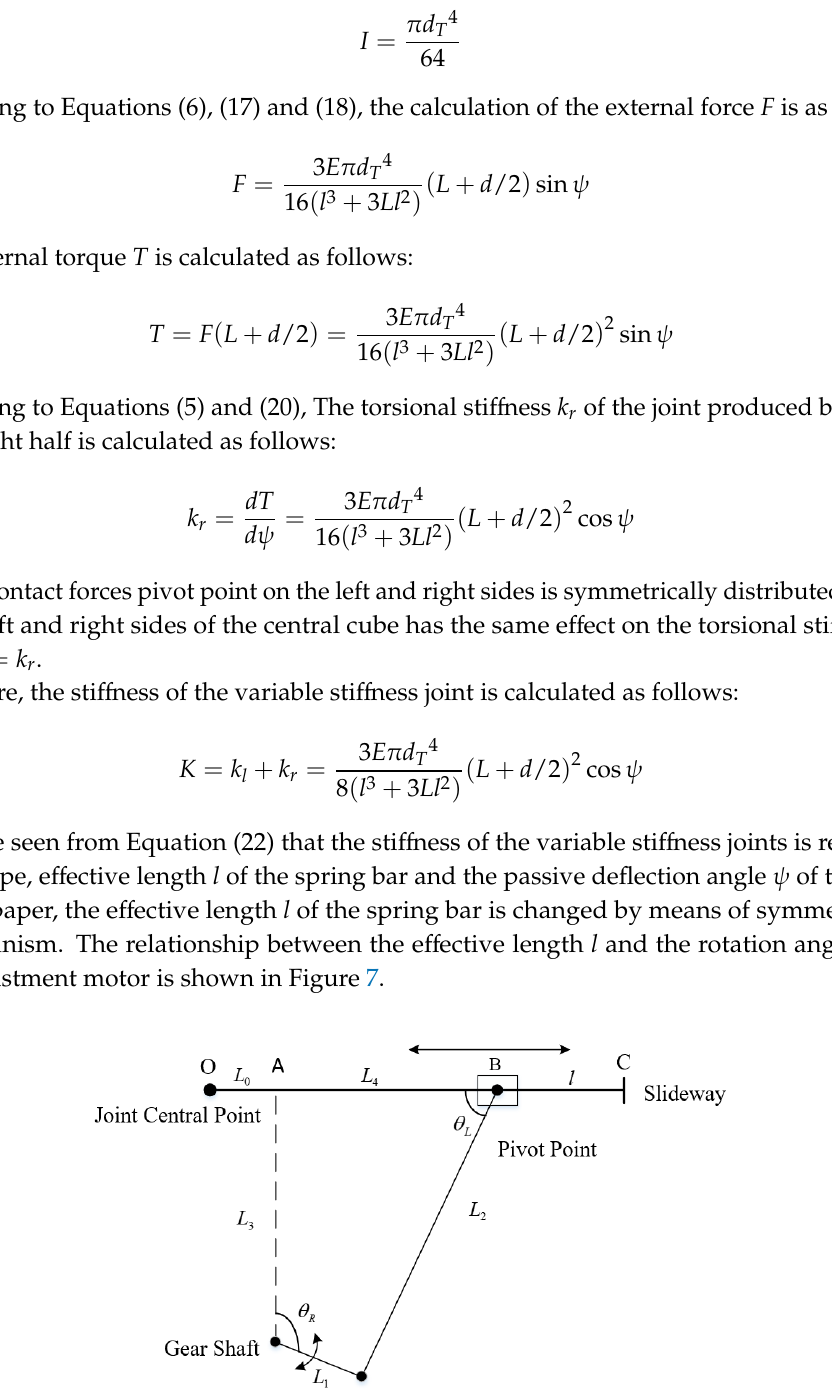
Figure 7. Schematic diagram of the crank slider mechanism.